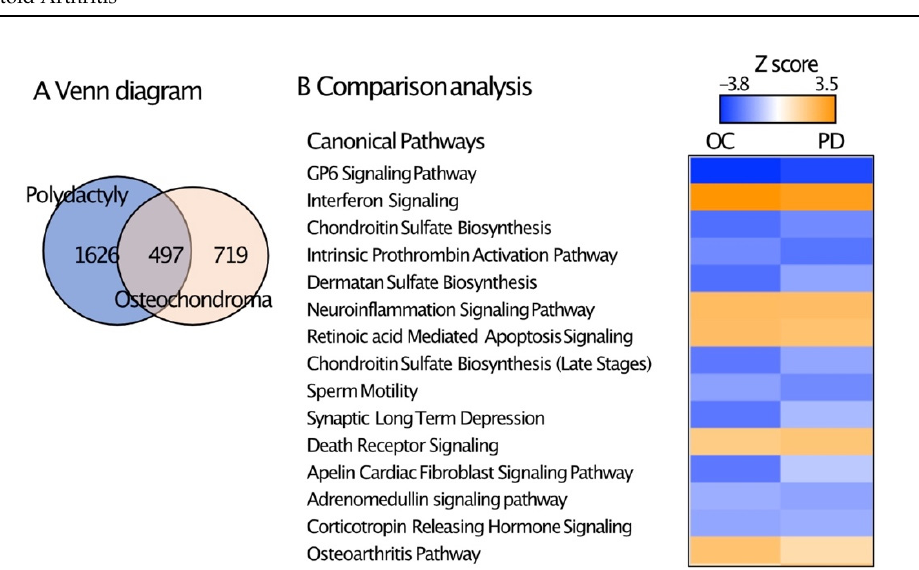
Figure 3. Comparison of DEGs between control and RAR γ -agonist treatment groups of osteochondroma explants with those of polydactyly chondrocyte cultures. The DEGs (criterion FDR ≤ 0.05 and the LFC cuto ff values of +/ − 1) between RAR γ agonists treatment and control groups were analyzed in the osteochondroma explant cultures (OC10) and human polydactyly chondrocytes. ( A ) Venn diagram analysis of DEGs of osteochondroma explants and polydactyly chondrocyte cultures. ( B ) Canonical pathways highly ranked by the comparative analysis of IPA.